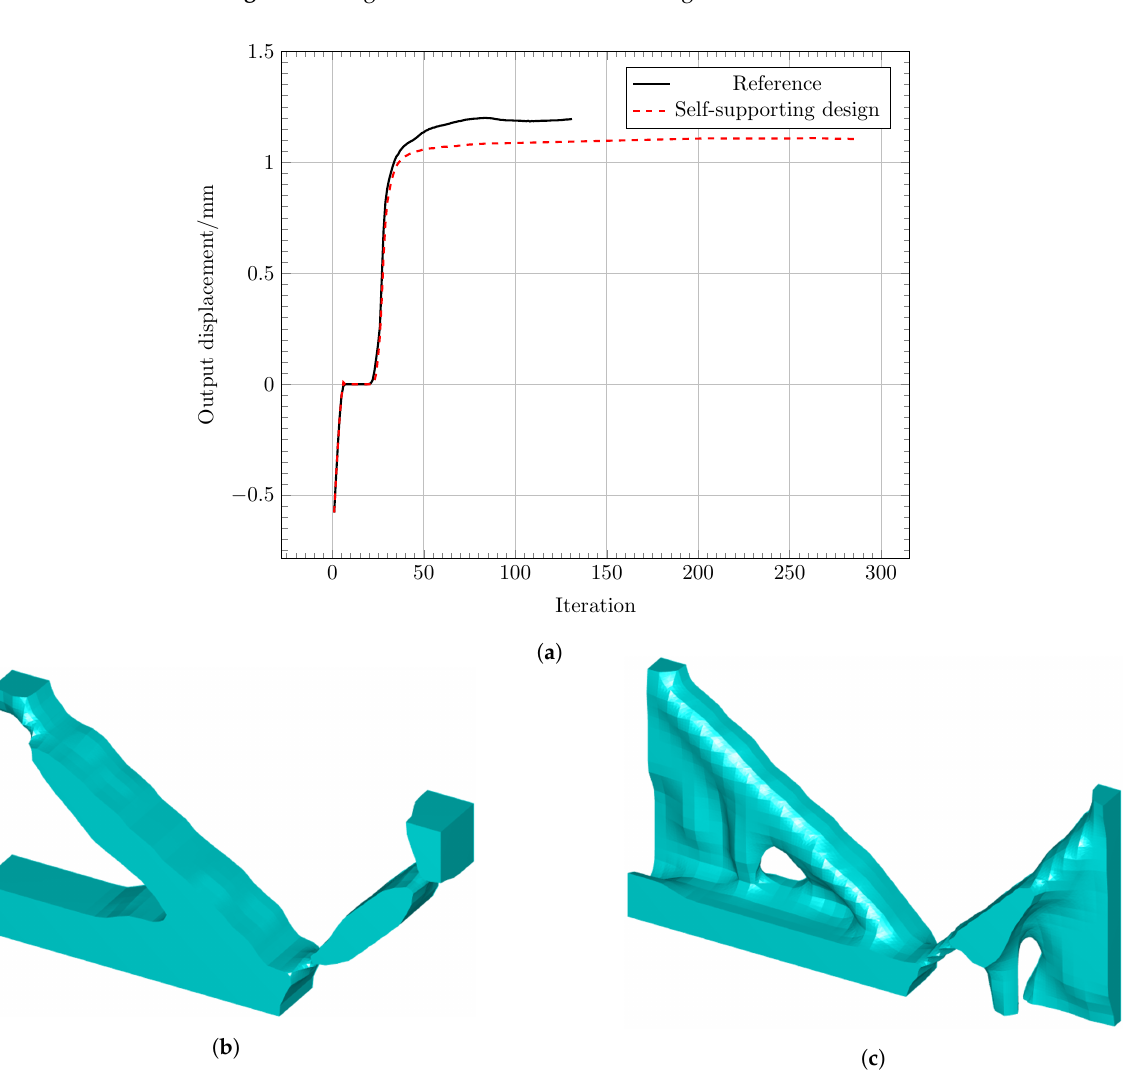
Figure 10. Convergence processes and optimized topologies solving the force inverter design case: ( a ) convergence processes, ( b ) reference, ( c ) self-supporting